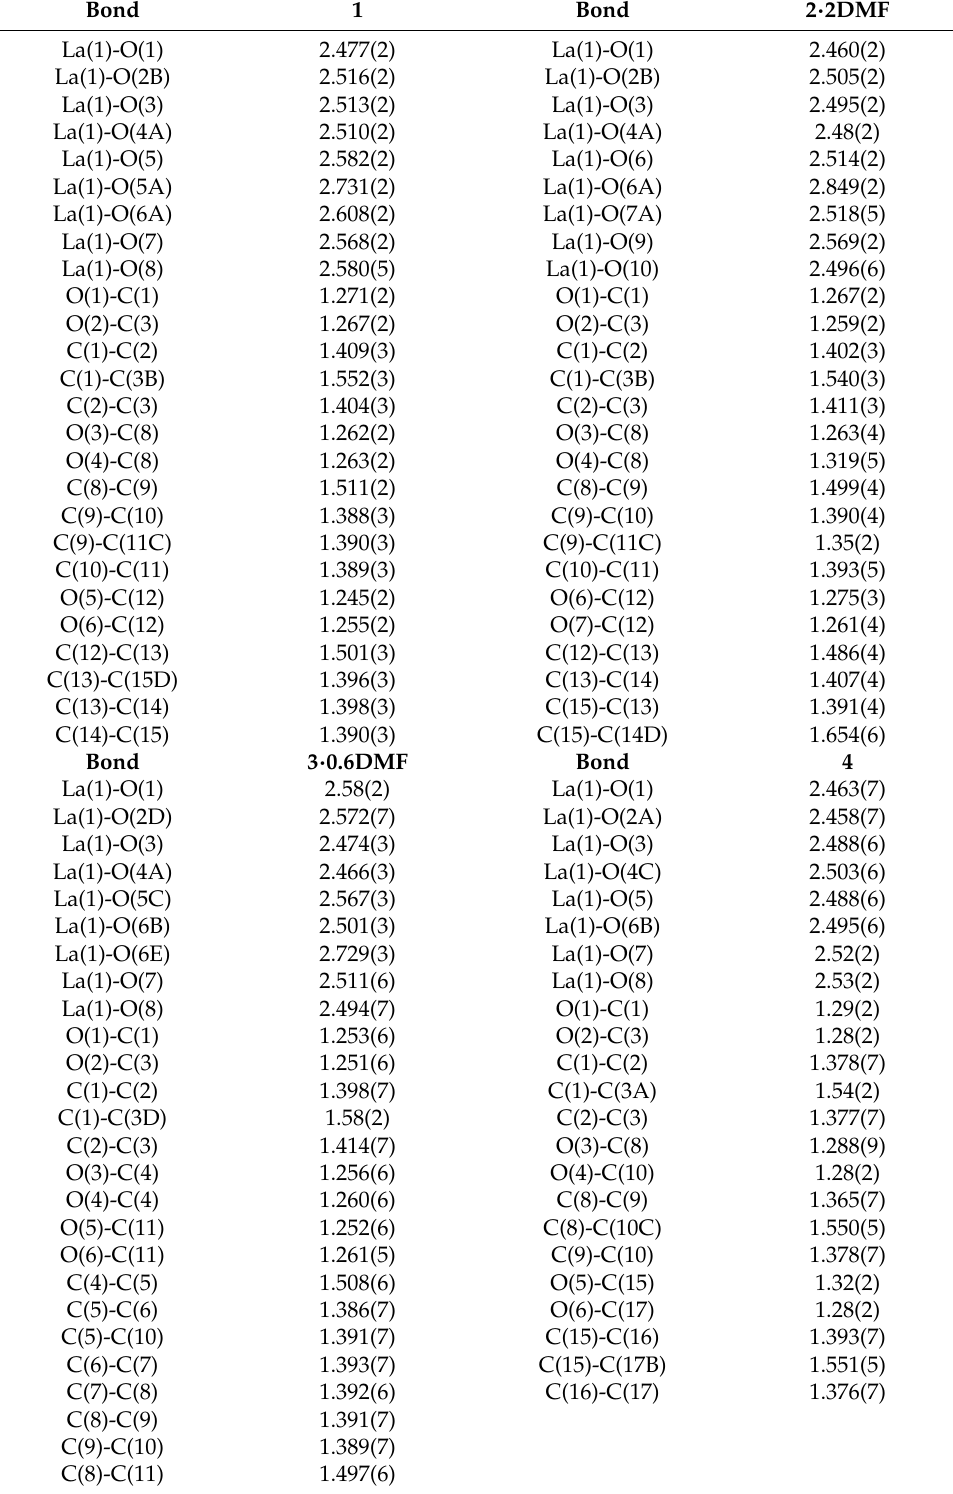
Table 1. Selected bond lengths (Å) in 1 – 4